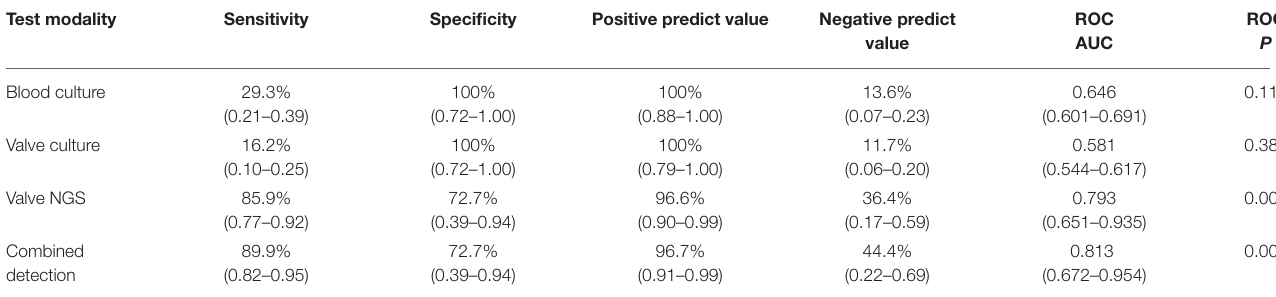
TABLE 2 | Diagnostic ability of different test modalities for patients with